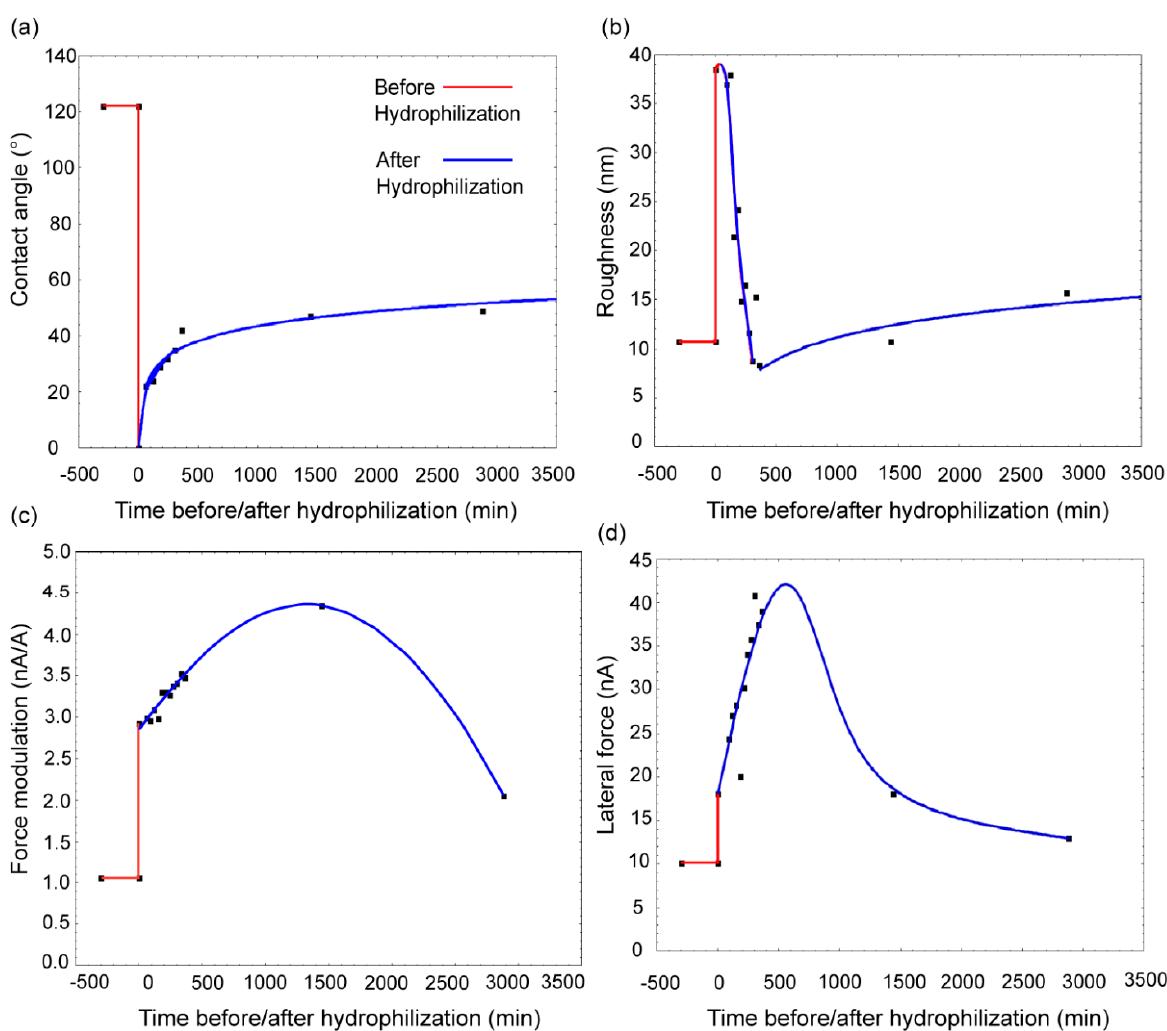
Figure 2. Evolution of physico-chemical properties of flat PDMS surfaces, prior to hydrophilization (red) and subsequently, i.e., during hydrophobic recovery (blue). ( a ) contact angle; ( b ) roughness; ( c ) force modulation; and ( d ) lateral force.